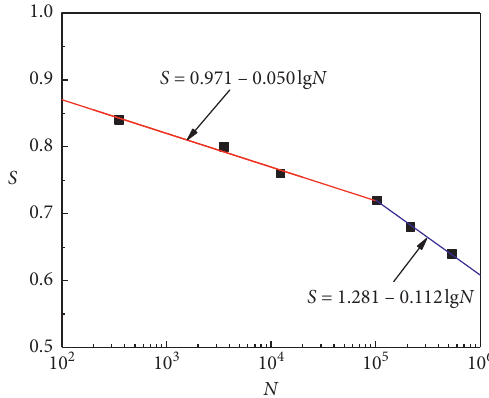
Figure 9: S - N curve of the FRP grid-concrete